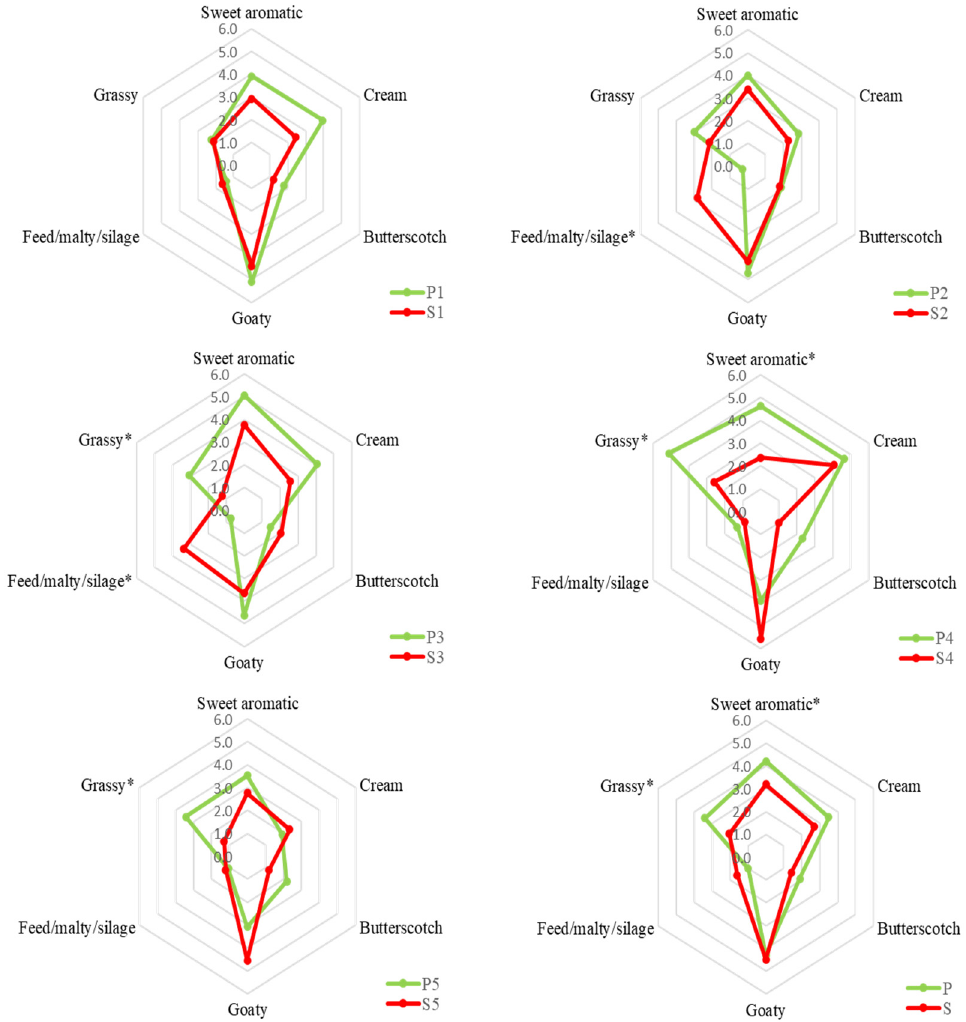
Figure 2. QDA results of bulk milk from pasture-fed goats (P) and stall-fed goats (S) of each period. The numbers 1 to 5 indicate the milking period (see Table 1 for further details). The asterisk (*) indicates a statistical difference ( p ≤ 0.05) between P and S milk samples.